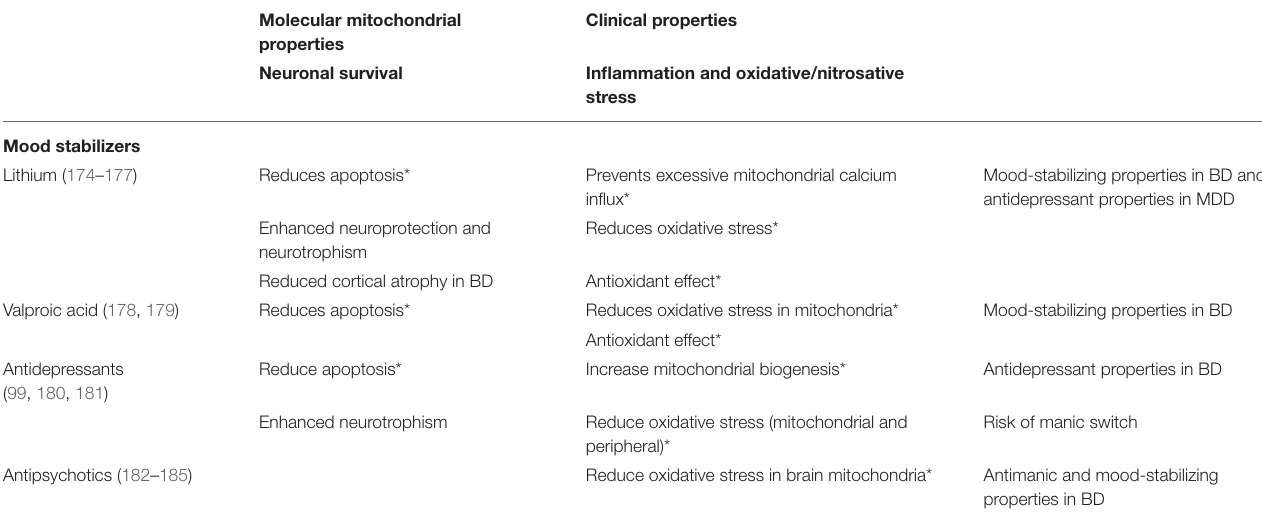
TABLE 1 | Effects of conventional pharmacotherapy on mitochondrial